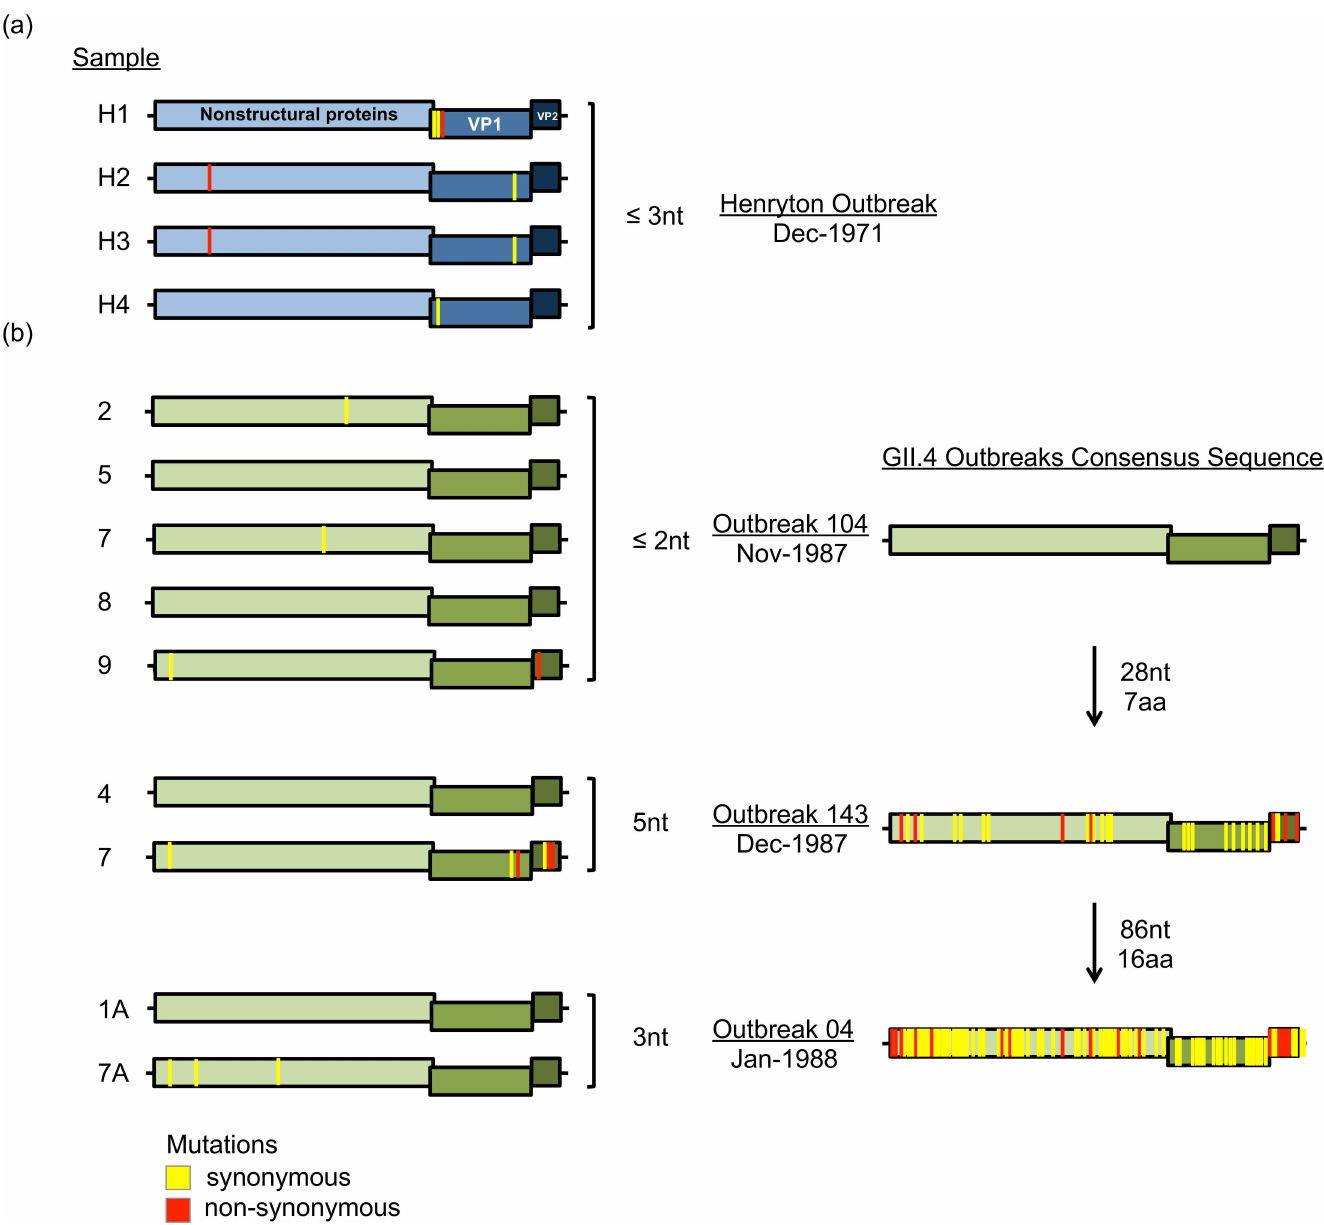
Fig 4. Inter-host diversity of noroviruses in immunocompetent individuals. Summary of NGS data from multiplepatient samples collectedduring discrete outbreaks. Genomes analyzedfrom the GII.6 outbreak were colored in blue (a), and those from the GII.4 outbreaks in green (b). All viral sequenceswere nearlyidentical( (cid:20) 5 nt differences) within each outbreak; however,GII.4 viruses accumulated over 80 nt mutationswithin a singleseason (3 months). Red (non-synonymous)and yellow (synonymous) bars indicate substitutions comparedwith the consensussequenceof the outbreak strain. Note that despite the occurrence of over 80 nt mutations throughoutthe genome of GII.4 strains within a singleseason, all mutationsthat mappedinto the VP1 were